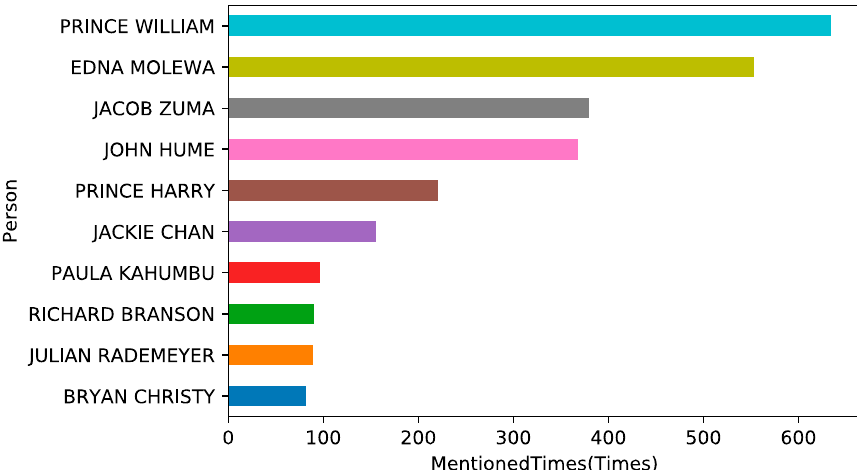
Figure 9. Information of people mentioned in tweets.